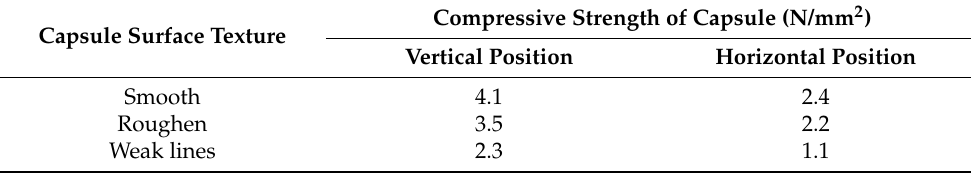
Table 4. Strength characteristic of the capsule at various capsule